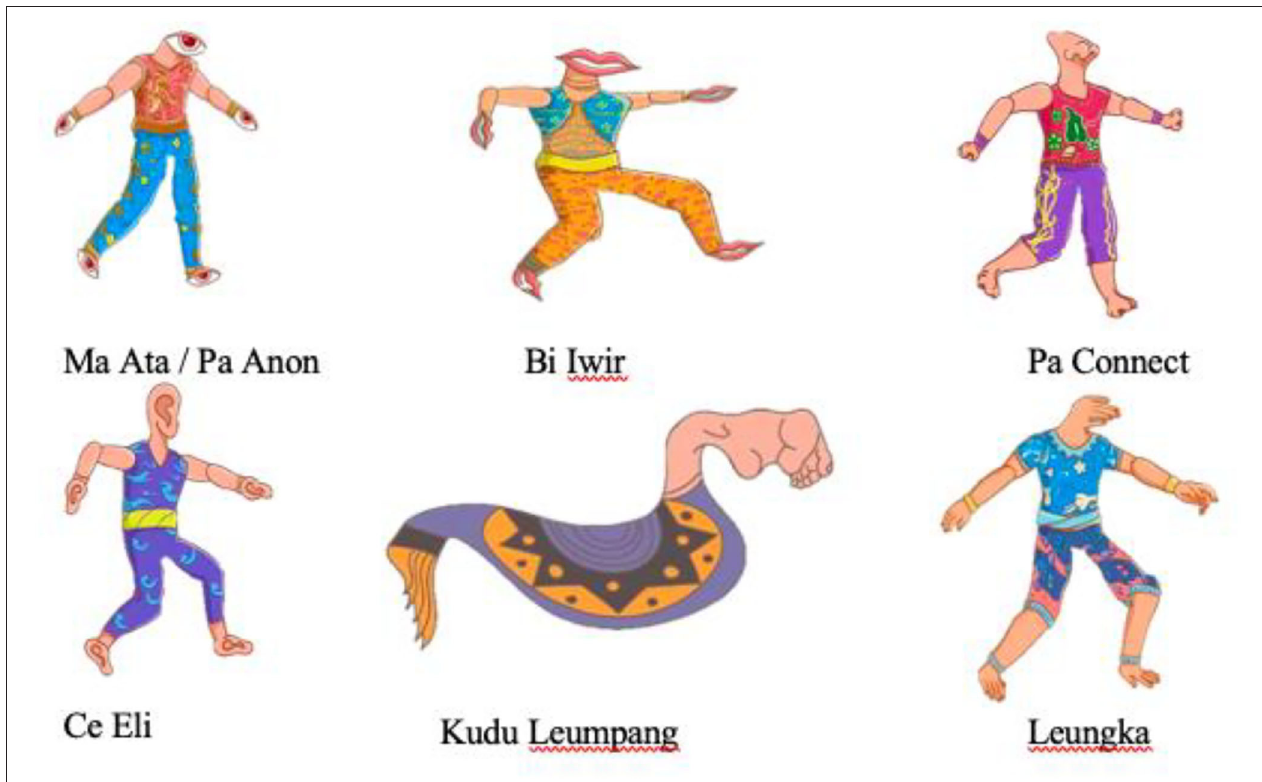
FIGURE 1 | The 6 characteristics of Sukuraga Puppets.